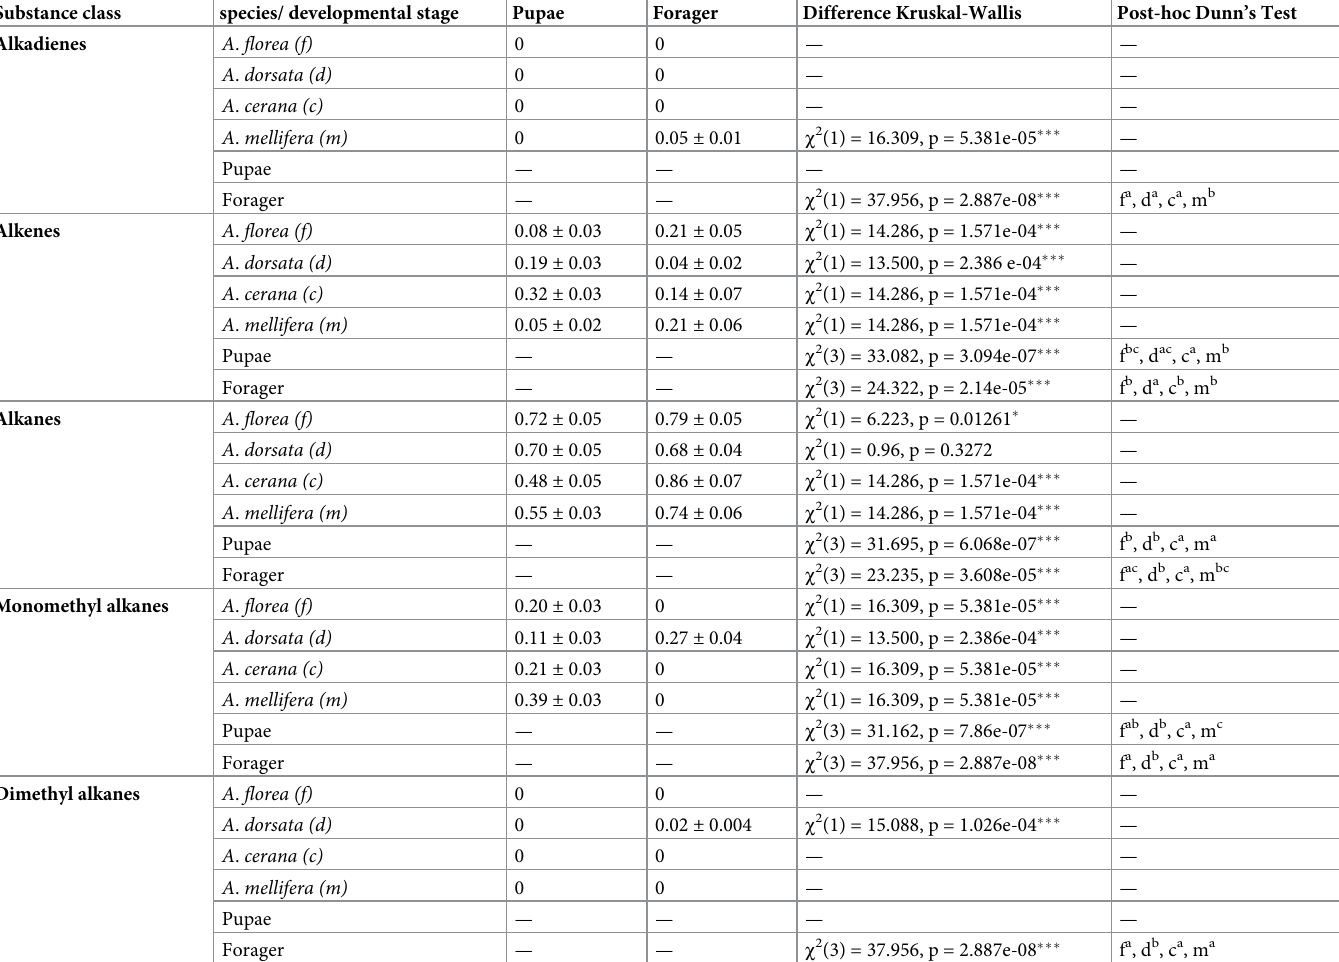
Table 4. Differences in mean ( ± SD) relative abundance of substance classes in the CHC profile of A . mellifera , A . cerana , A . florea and A . dorsata for pupae and foragers. Substance class